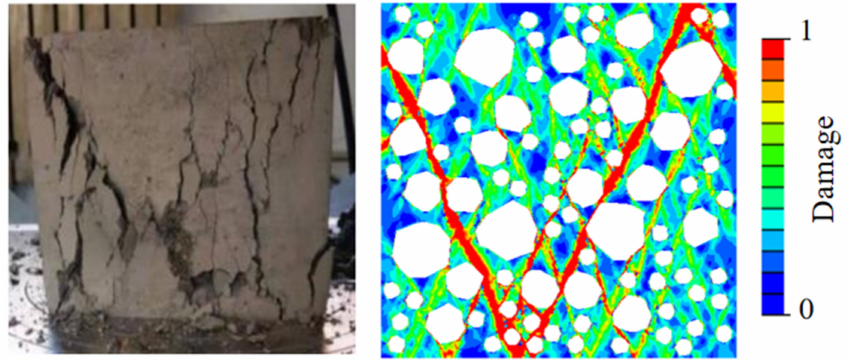
Figure 7. A comparison of the failure modes of compressive specimens.